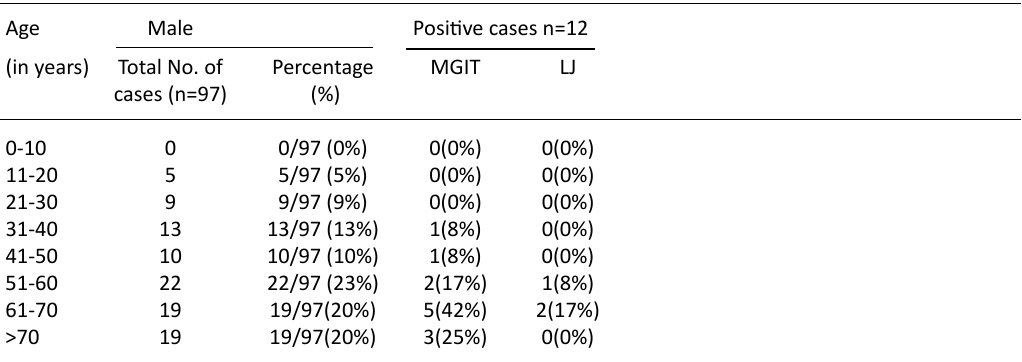
Table 4 (a). Gender wise distribution of suspected cases (Male) (n=97)